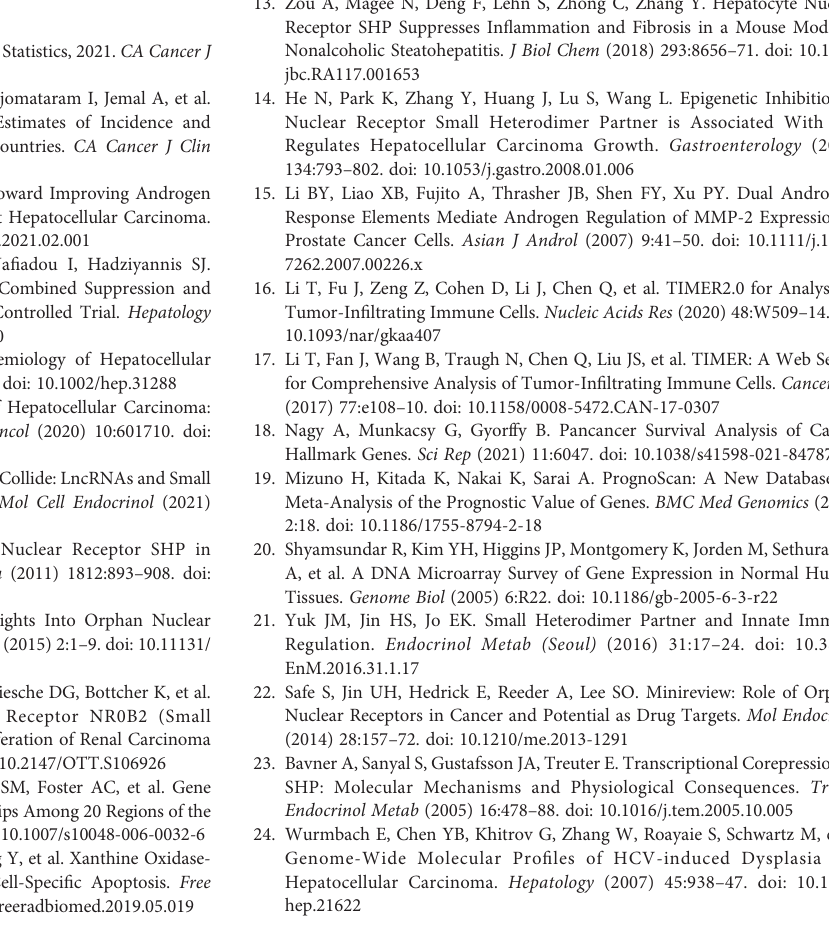
Supplementary Figure 1 | NR0B2 gene expression pro fi les in human tissues were queried from the Roth cDNA microarray dataset (11) in the Oncomine database. Box plot was generated based on the log 2 median-centered ratio in each organ/tissue type. Supplementary Figure 2 | The overall survival pro fi les were analyzed with the Kaplan-Meier Plotter based on NR0B2 expression in multiple human cancers. The hazard ratio with 95% con fi dence intervals and log-rank p-value and case numbers in each group were inserted in the plot. Supplementary Table 1 | NR0B2 gene expression down-regulation in human cancers. Comparative data of NR0B2 gene expression pro fi les in human malignant and benign counterpart tissues were obtained from the Oncomine database. Supplementary Table 2 | NR0B2 gene expression up-regulation in human cancers. Comparative data of NR0B2 gene expression pro fi les in human malignant and benign counterpart tissues were obtained from the Oncomine